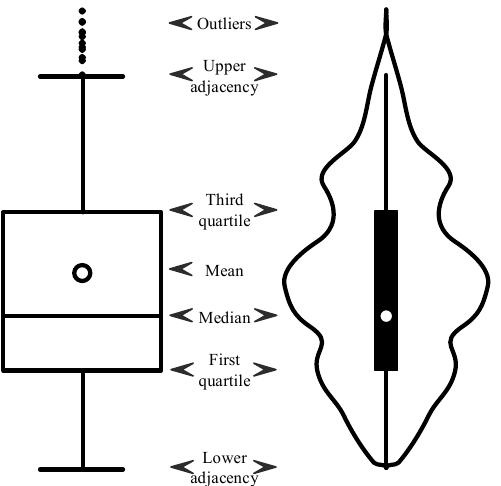
Figure 6. Comparison of the components of the violin and box plots.